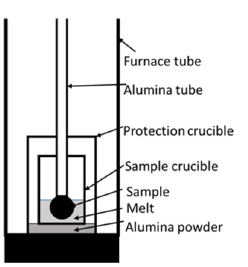
Figure 1. Test setup of the high-temperature tube furnace. Table 1. Characteristics of the test setup components. Table 1. Characteristics of the test setup